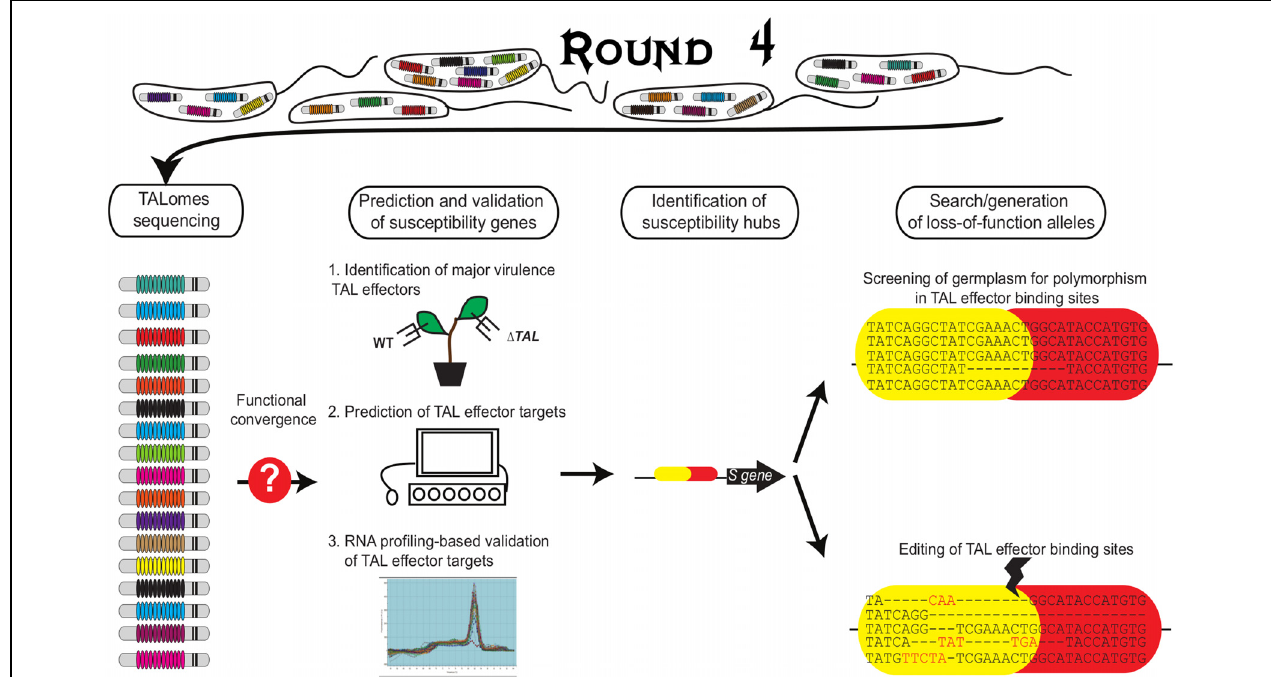
FIGURE 3 | Exploiting TAL effector knowledge to identify S genes and loss-of-function alleles. Based on diversity studies conducted on a particular Xanthomonas species, it is possible to direct the research for virulence targets from the most prevalent TAL effectors. Field surveys allow the collection of strains at a regional or national scale. All or representative ones are selected to characterize the TALomes, i.e., their complete repertory of TAL effectors. The corresponding S genes can be identified employing three complementary strategies. First, the expected major virulence role of a prevalent TAL effector has to be assessed in planta (by loss of function mutational analysis or heterologous expression for example). Second, different bioinformatics algorithms (TALVEZ, TAL Effector Nucleotide Targeter,